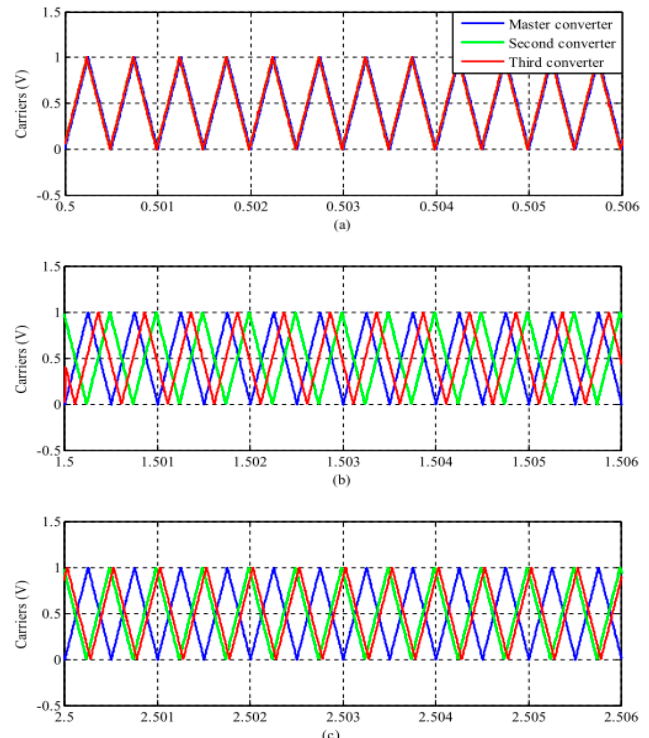
Figure 14 . (Case 2) Carriers phase angles for case 2. ( a ) Carriers at t = 0.5 s; ( b ) Carriers at t = 1.5 s; ( c ) Carriers at t = 2.5 s.